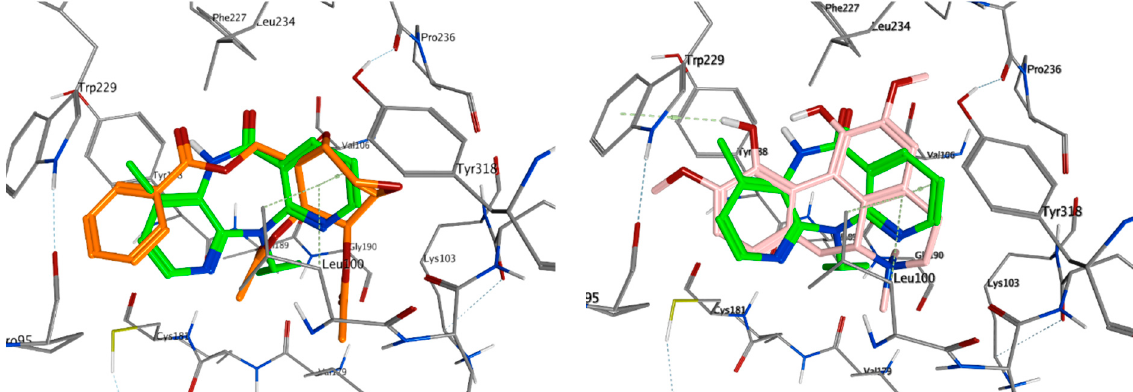
Figure 3. Overlay of top scoring ligands crotepoxide 14 (orange) and magnoflorine 13 (pink) with known inhibitor Nevirapine (green) in the non-nucleoside inhibitor binding pocket portion of reverse transcriptase RT (PDB ID 1JLB).